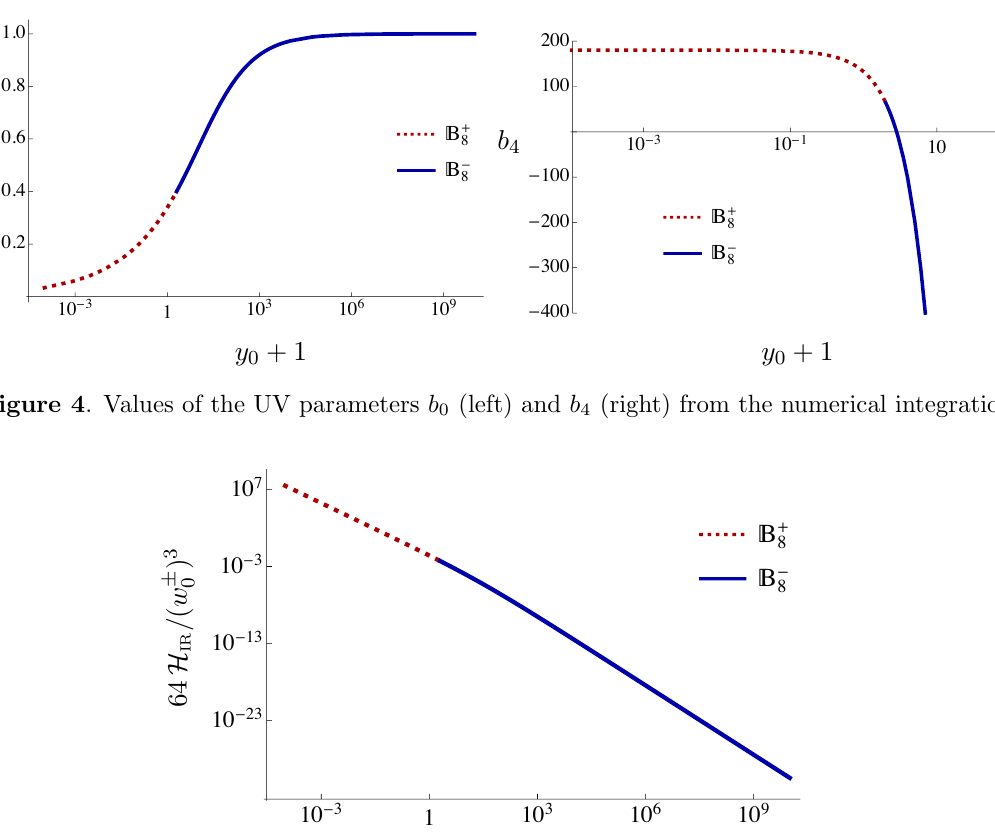
from the numerical IR